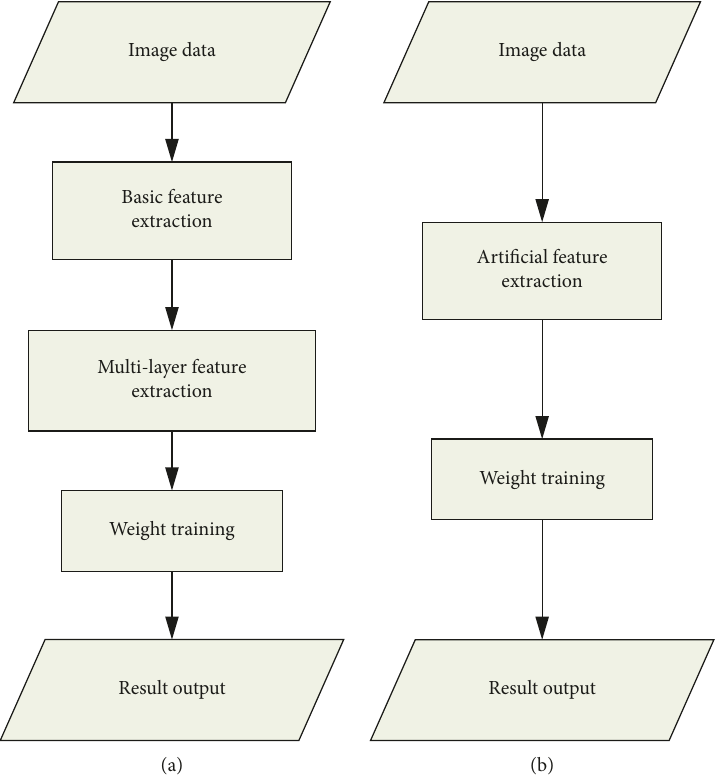
Figure 2: Comparison between deep learning model and traditional machine learning algorithm. (a) Deep learning algorithm. (b) Traditional machine learning algorithm.